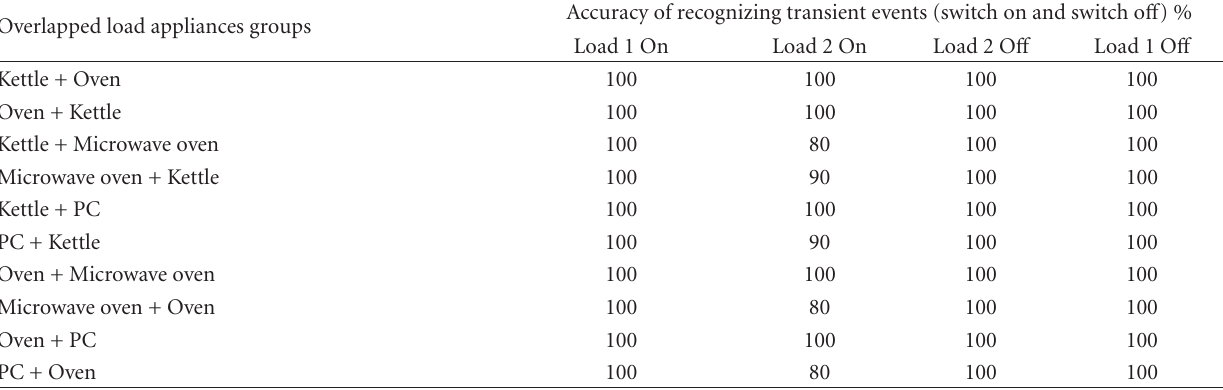
Table 2: Result of ESA on four typical